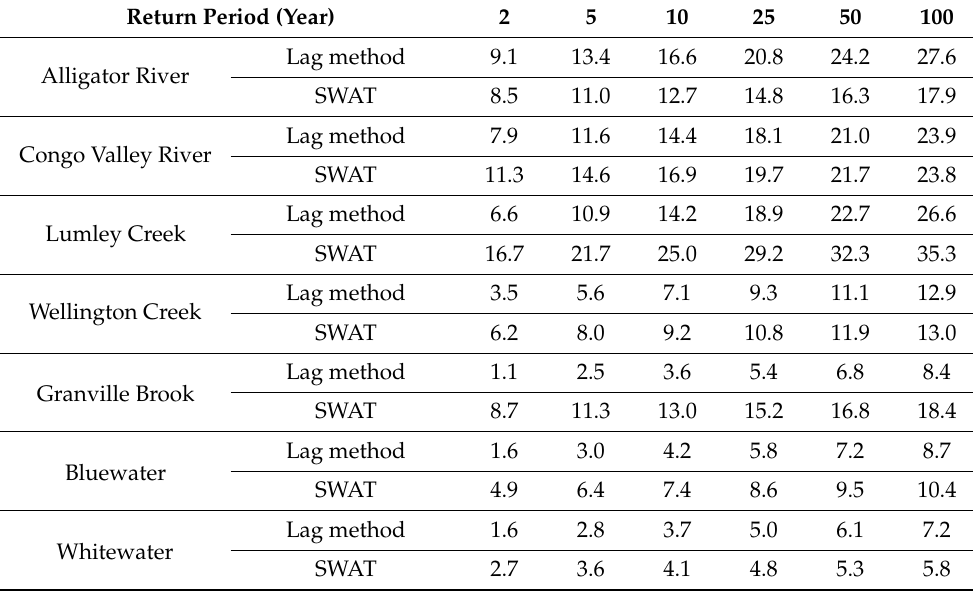
Table 4. Comparison of peak discharges (m 3 /s) for baseline LULC